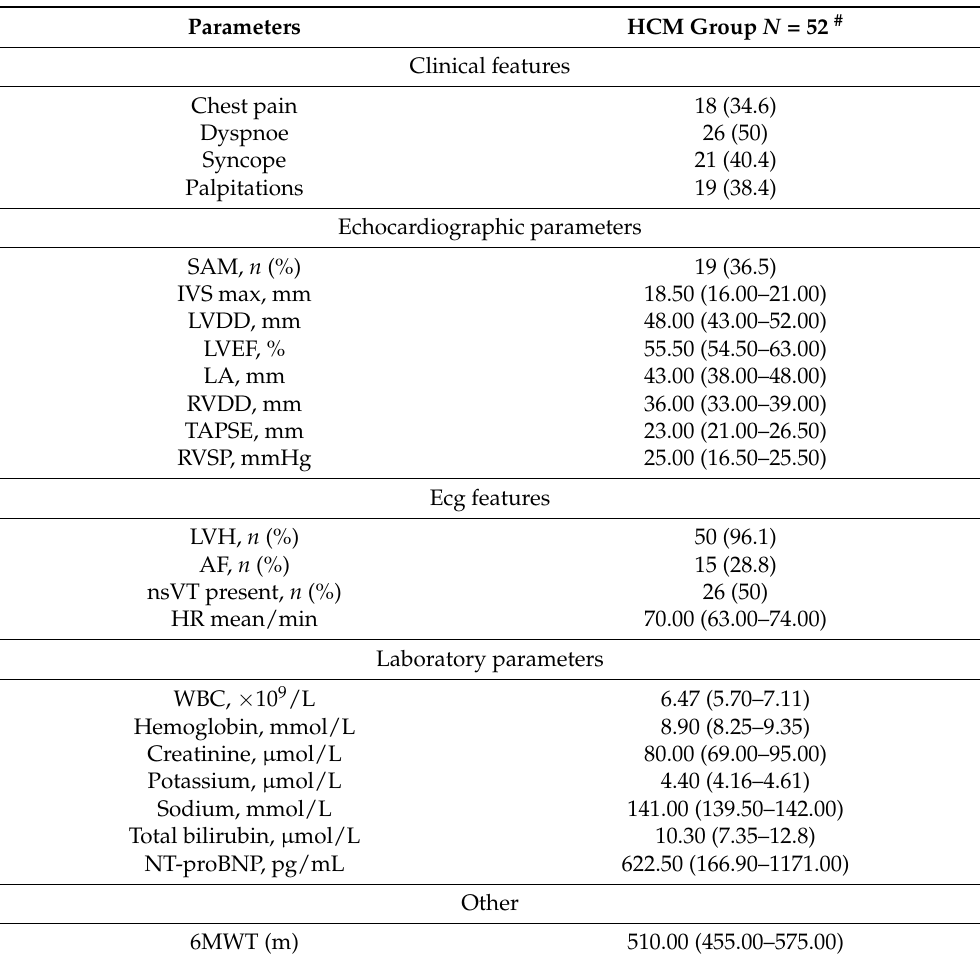
Table 3. Baseline characteristics of patients with HCM.